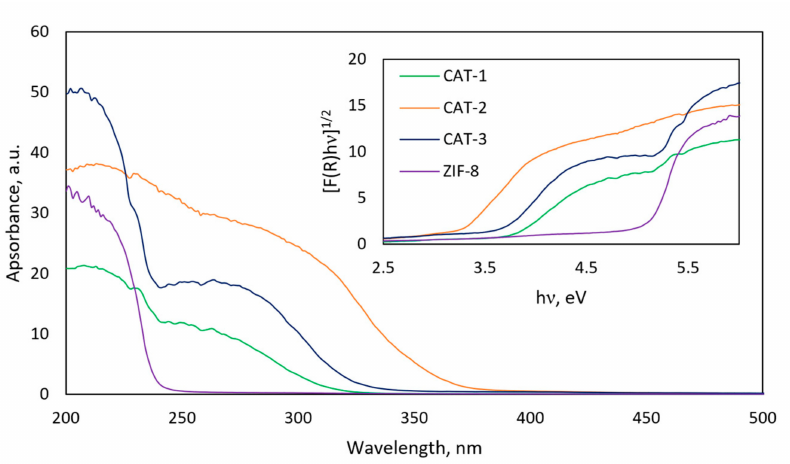
Figure 3. UV-Vis diffuse reflectance spectra and the Kubelka–Munk function of the studied sam- ples